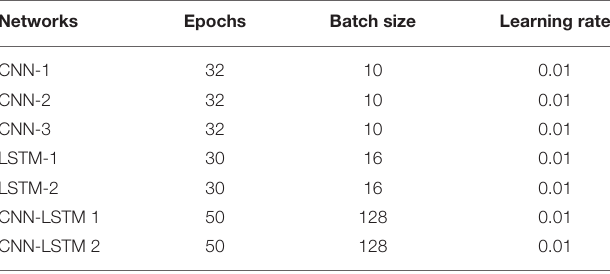
TABLE 9 | The final selected values for batch size and hyperparameters of the proposed DL networks. Networks